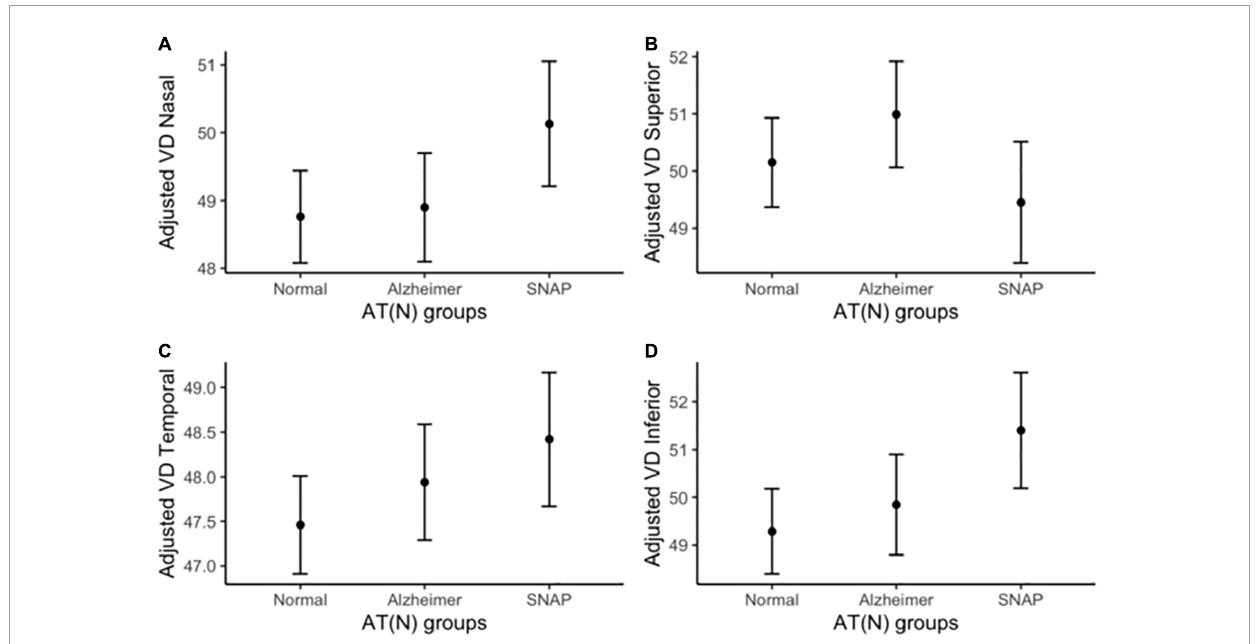
FIGURE2 Adjusted macular VD measurements by AT(N) group. Macular VD differences among diagnostic groups in (A) nasal, (B) superior, (C) temporal, and (D) inferior quadrants. Macular VD measurements are adjusted by age, APOE ε 4 status, hypertension, diabetes mellitus, dyslipidemia, heart disease, COPD and smoking habit. COPD, chronic obstructive pulmonary disease; n.s., non-significant; SNAP, suspected non-Alzheimer pathology; VD, vessel density.